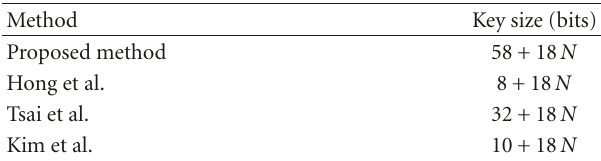
Table 1: Key size